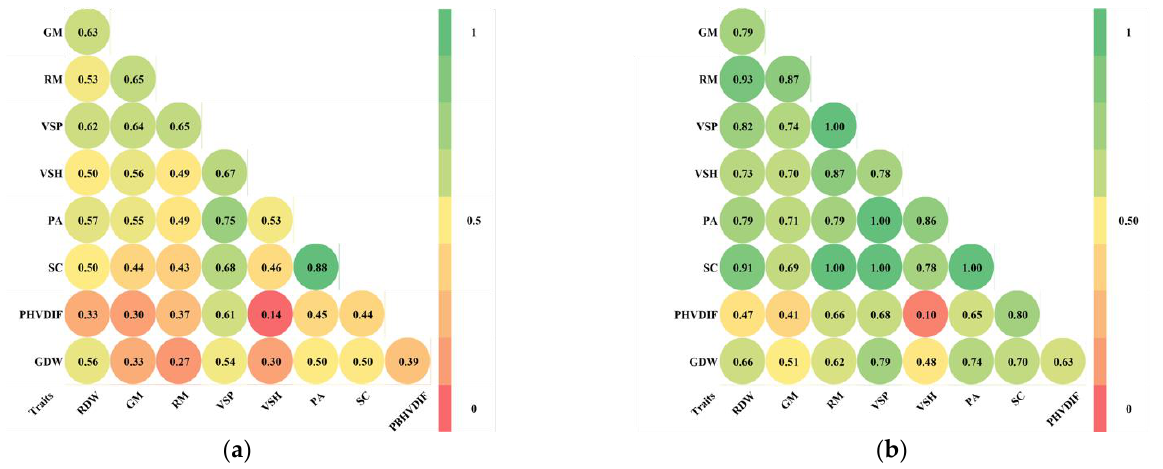
Figure 3. Correlation of traits with significance of p > 0.05. ( a ) Phenotypic correlation; ( b ) genotypic correlation. Trait: VSP—visual scale of the plant at 45 DAA; VSH—visual scale of husk leaves at 45 DAA; PHVDIF—the difference between the visual scale of plant and husk at 45 DAA; PA—photosynthesis activity at 45 DAA; SC—stomatal conductance at 45 DAA; GDW—grain dry weight; RDW—residual dry weight; GM—grain moisture; RM—residual moisture.